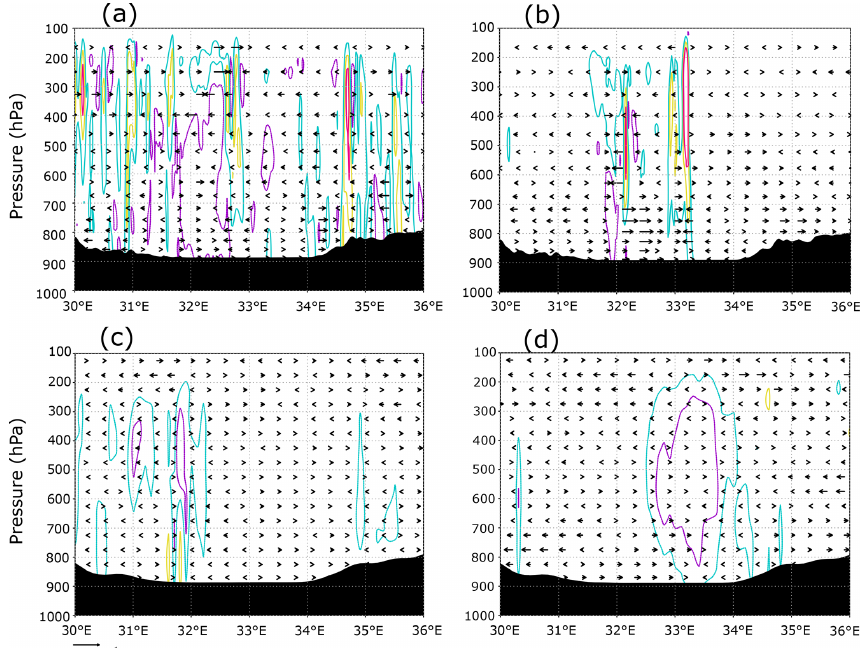
Figure 9. Cross section through 1 ◦ S (black line in Fig. 8b) of the zonal-wind anomaly (0–2 ◦ S) vectors and the mean contoured vertical velocity (ms − 1 ) over 0–2 ◦ S at (a) 12:00Z, 29 November, and (b) 06:00Z, 30 November, from the 3km simulation. Purple dashed contours indicate − 0 . 1ms − 1 , light blue contours indicate 0.1ms − 1 , yellow contours indicate 0.3ms − 1 , and red contours indicate 0.5ms − 1 . Lake Victoria extends from about 32 to 34 ◦ E. The bottom two panels show the same as in (a) and (b) but from the 12km simulation at (c) 12:00Z, 29 November, and (d) 06:00Z, 30 November. Purple dashed contours indicate − 0 . 01hPas − 1 , light blue dashed contours indicate − 0 . 005hPas − 1 , and yellow dashed contours indicate 0.005hPas − 1